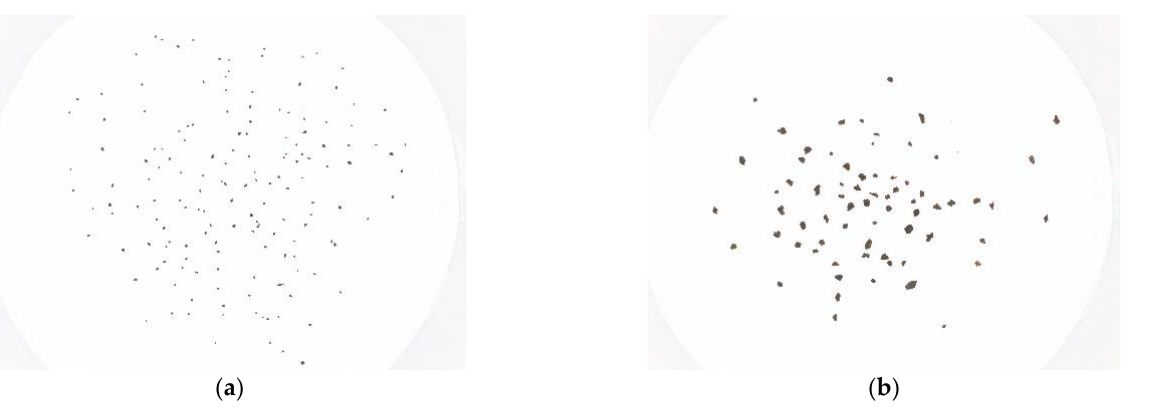
Figure 10. Pictures acquired by the vision system using four samples of real volcanic ash particles: